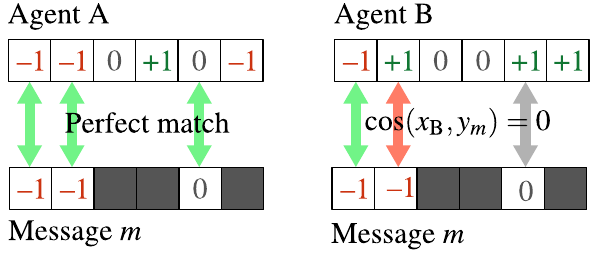
Figure 1. Opinion vectors for agents A and B differ, so message m that matches A perfectly will most likely not fit B. An example for opinion vectors with D = 6 components, with message m having length